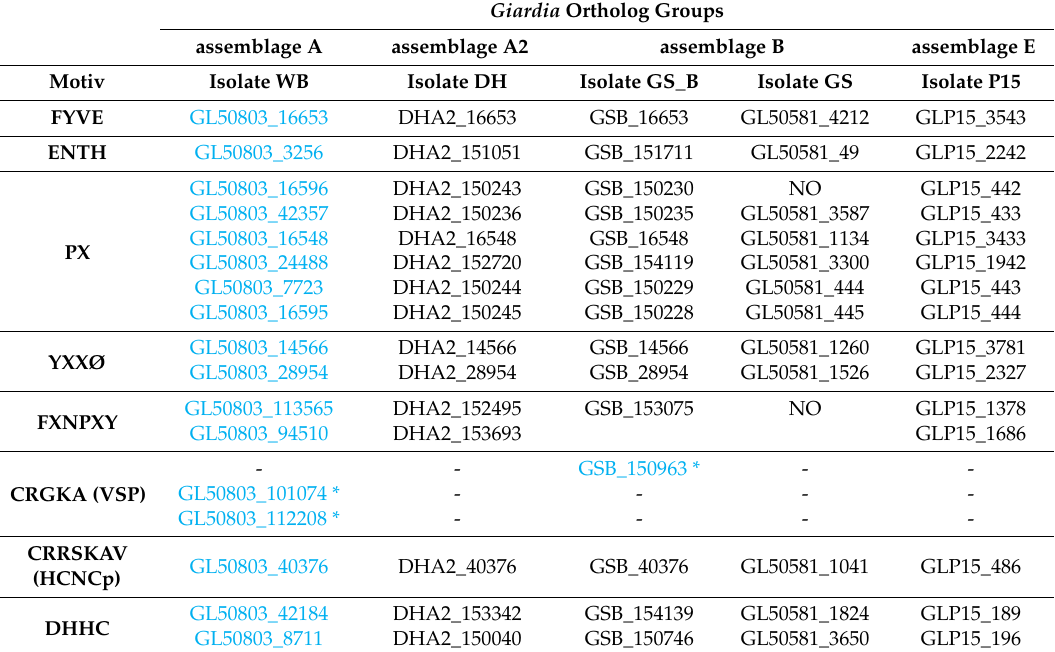
Table 2. Orthologs of the membrane-associated proteins of Giardia described in the EuPathDB GDB (http://giardiadb.org/giardiadb/). The Gene ID numbers of the proteins described in this work are denoted in light blue. NO: no orthologs. The VSPs are assemblage-specific